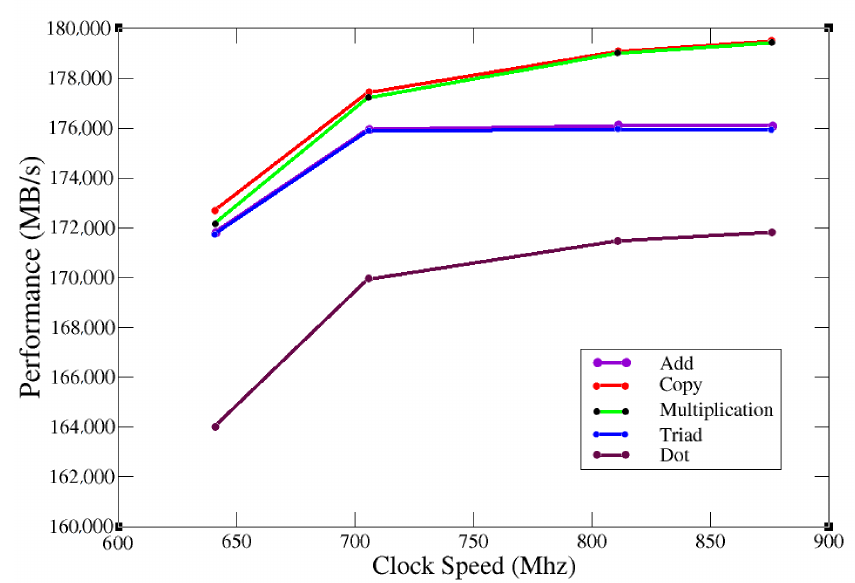
Figure 11. K80 performance